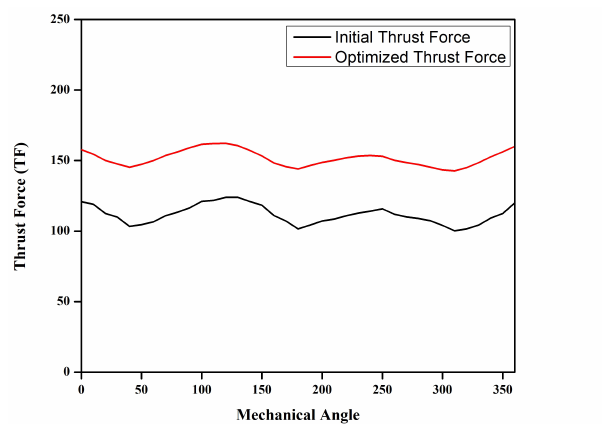
Figure 10. Thrust force comparison before and after